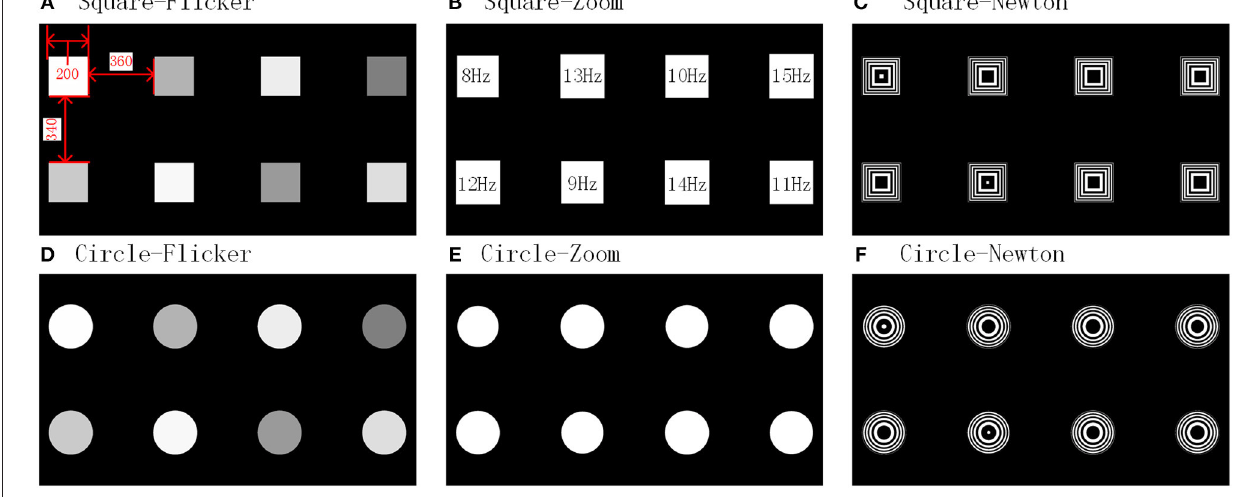
FIGURE 2 | Paradigm interfaces.